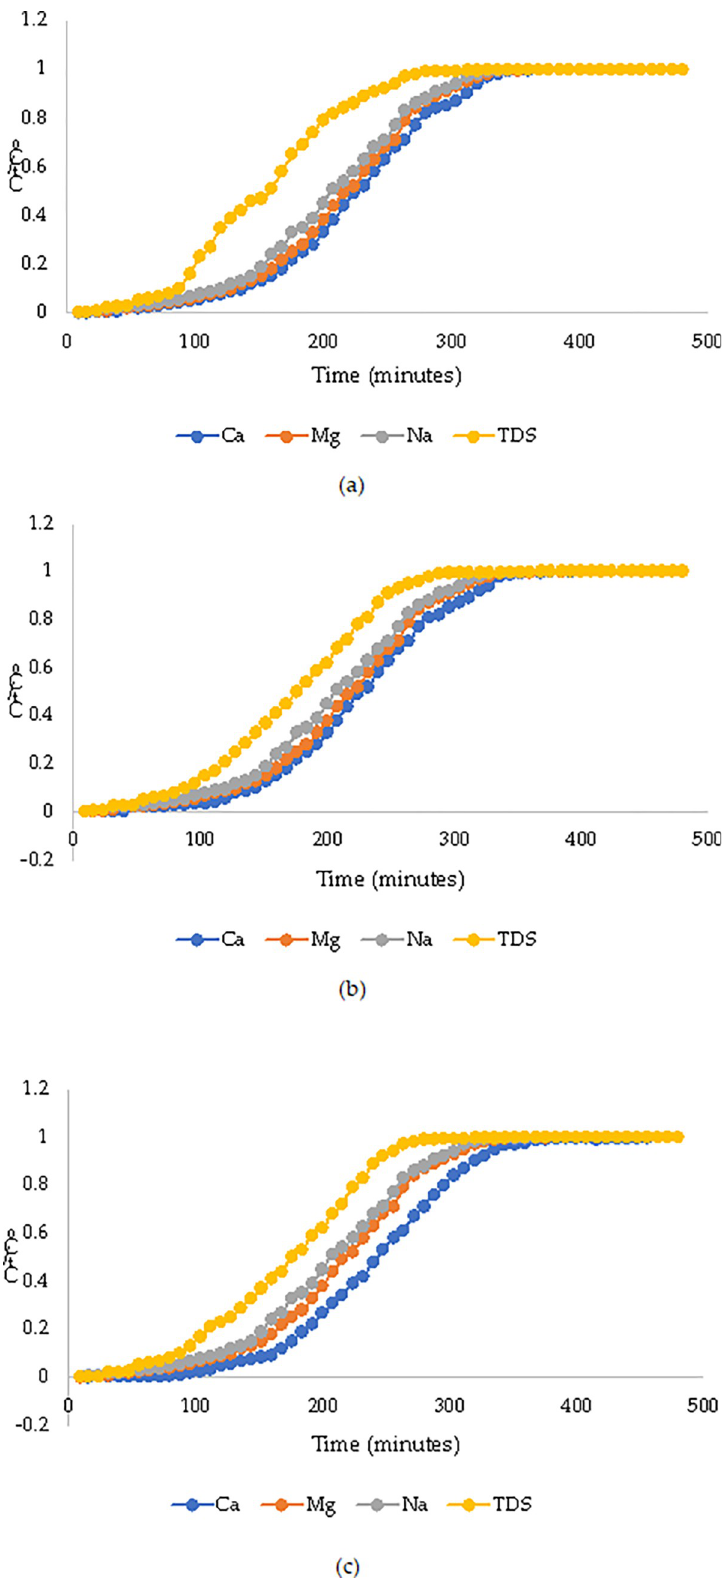
Fig 7. Material breakthrough curves (a) 0.5 m (b) 0.75 m (c) 1